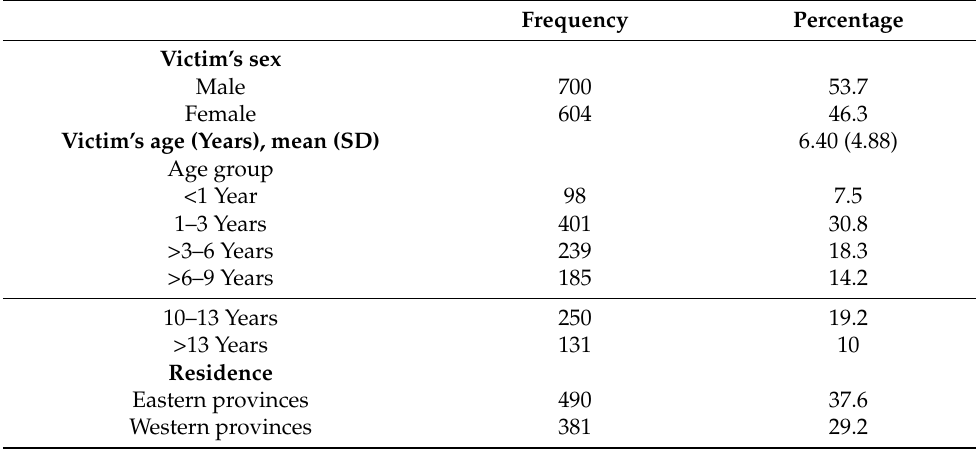
Table 1. Descriptive analysis of the sociodemographic characteristics of the victims of child maltreat- ment in Saudi